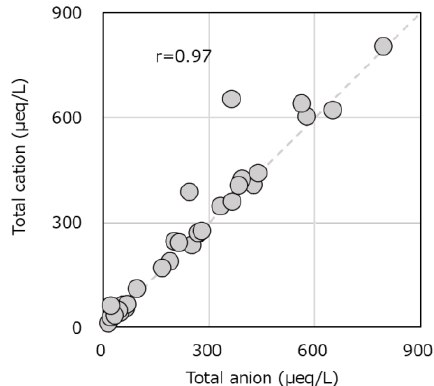
Figure 4. Relationship between the total anions and cations in the monthly precipitation at Hirosaki City (2018 to 2020).